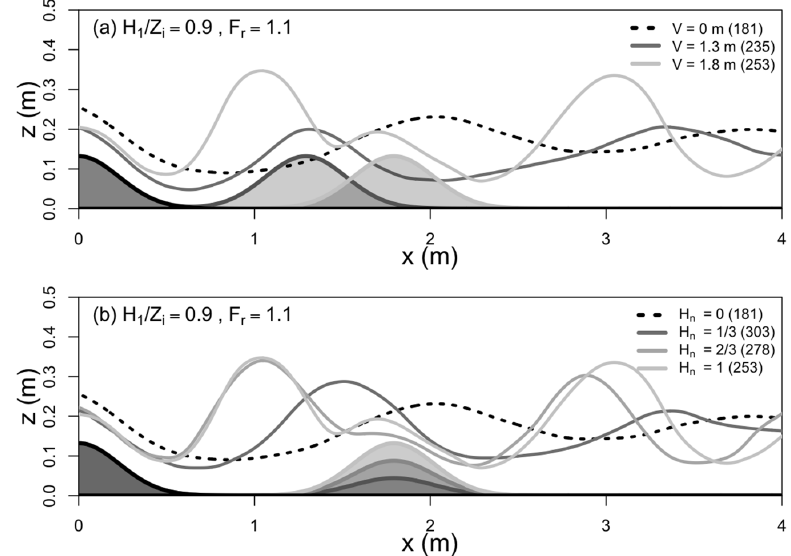
Sachsperger et al. [41] with NH 1 /U equal to 0.5. Crosses correspond to cases of valley flushing.